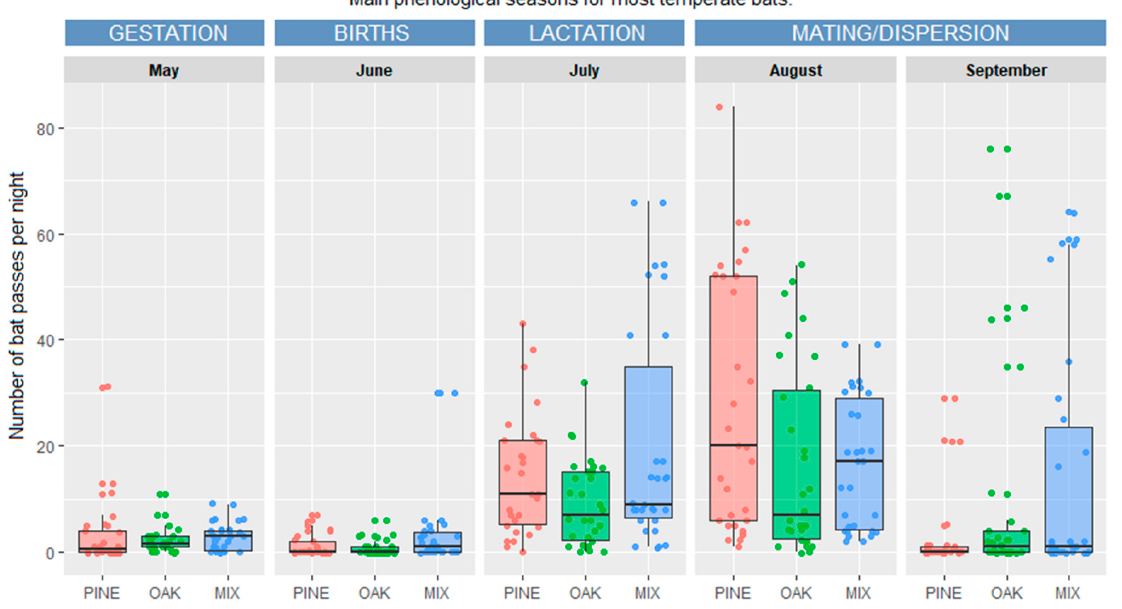
Figure 3. Bat foraging activity in coniferous (PINE), mixed (MIX), and deciduous (OAK) forests for main phenological seasons characteristic for most temperate bats (from May to September). Table 3. Mean number of bat passes recorded in different months (phenological seasons) for conif- erous, mixed, and deciduous forests. Different letters indicate significant differences in bat activity between months ( p < 0.05).